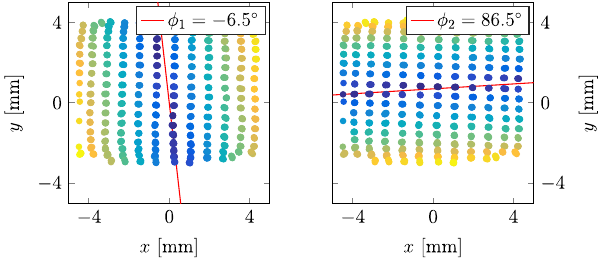
FIG. 9. Normalized amplitude of the first dipole mode at the upstream coupler (left) and of the second mode at the downstream coupler (right) at cavity two in ACC2 as a function of beam offset x and y . The dots are color coded by the relative signal strength, giving a bright yellow point at 1 and a dark blue point at 0. The red lines indicate the fitted polarization axes for both